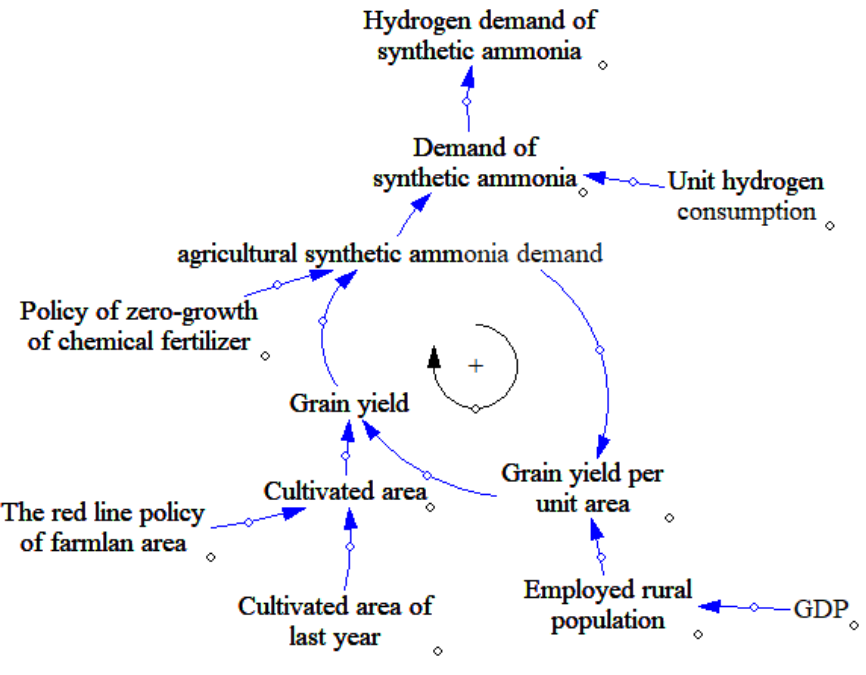
Figure 3. Model of synthetic ammonia